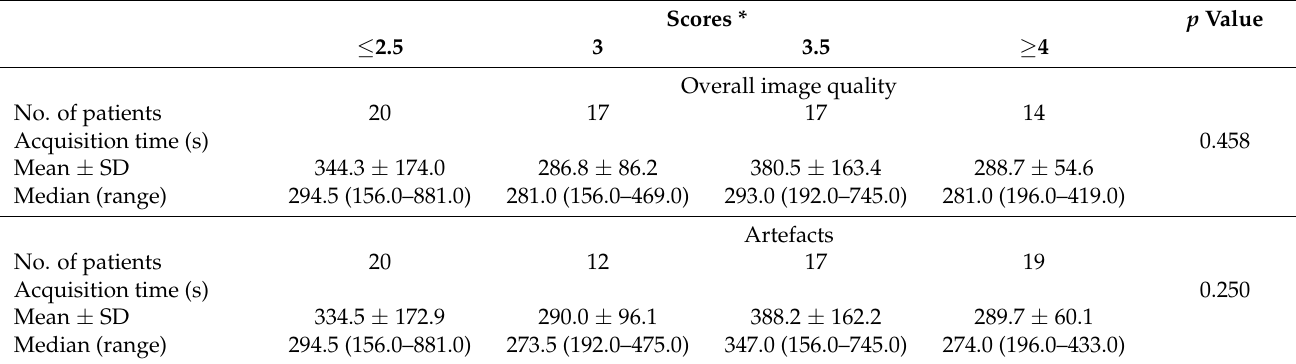
Table A4. Overall image quality and presence of artefacts according to the acquisition time for RT-MRCP